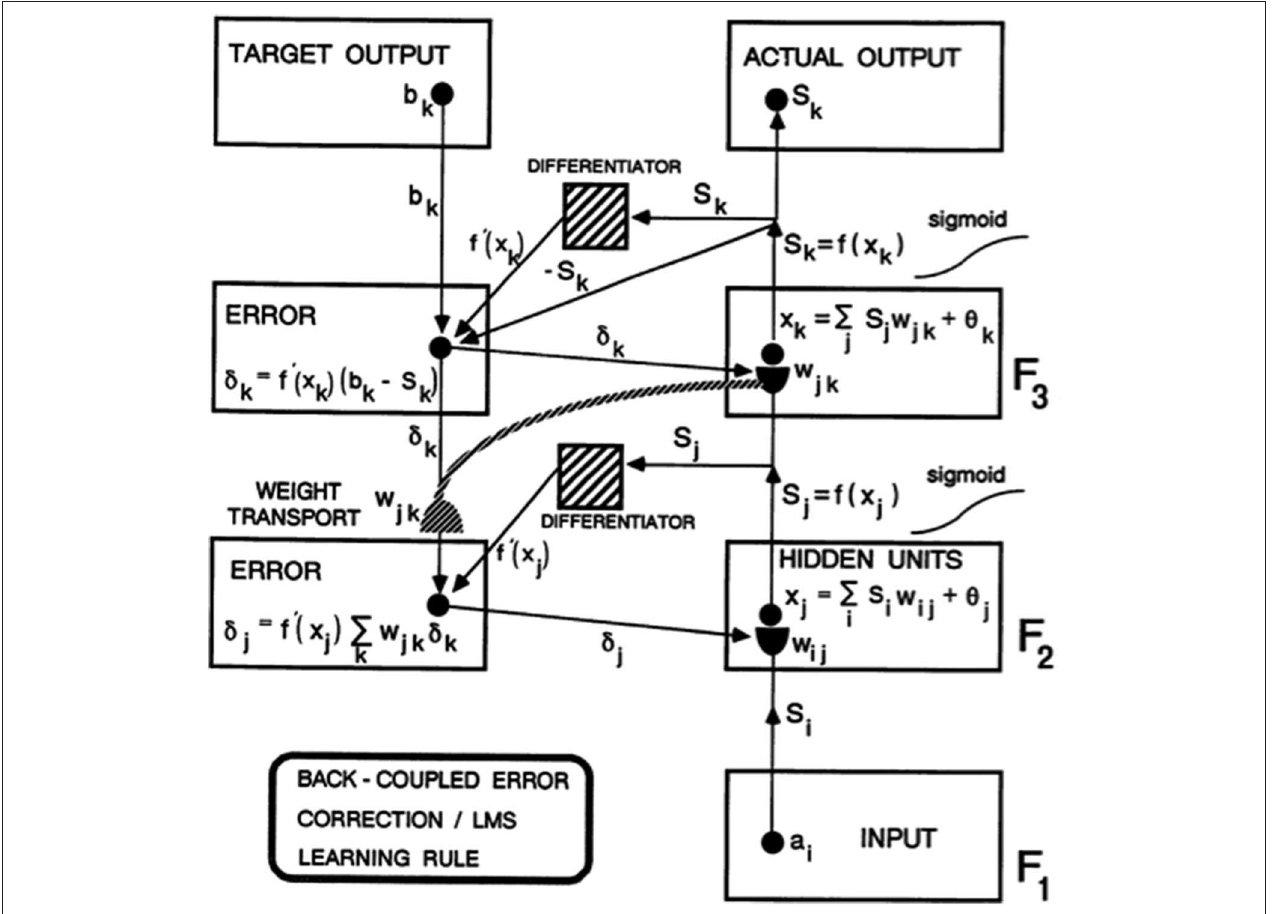
FIGURE 1 | Circuit diagram of the back propagation model. Input vector a i in level F 1 sends a sigmoid signal S i = f(a i ) that is multiplied by learned weights w ij on their way to level F 2 . These LTM-weighted signals are added together at F 2 with a bias term θ j to define x j . A sigmoid signal S j = f(x j ) then generates outputs from F 2 that activate two pathways. One pathway inputs to a Differentiator. The other pathway gets multiplied by adaptive weight w jk on the way to level F 3 . At level F 3 , the weighted signals are added together with a bias term θ k to define x k . A sigmoid signal S k = f(x k ) from F 3 defines the Actual Output of the system. This Actual Output S k is subtracted from a Target Output b k via a back-coupled error correction step. The difference b k – S k is also multiplied by the term f ′ (x k ) that is computed at the Differentiator from level F 3 . One function of the Differentiator step is to ensure that the activities and weights remain in a bounded range, because if x k grows too large, then f ′ (x k ) approaches zero. The net effect of these operations is to compute the Error δ k = f ′ (x k )(b k – S k ) that sends a top-down output signal to the level just below it. On the way, each δ k is multiplied by the bottom-up learned weights w jk at F 3 . These weights reach the pathways that carry δ k via the process of weight transport . Weight transport is clearly a non-local operation relative to the network connections that carry locally computed signals. All the δ k are multiplied by the transported weights w jk and added. This sum is multiplied by another Differentiator term f ′ (x i ) from level F 2 to keep the resultant product δ j bounded. δ j is then back-coupled to adjust all the weights w ij in pathways from level F 1 to F 2 [figure reprinted and text adapted with permission from Carpenter